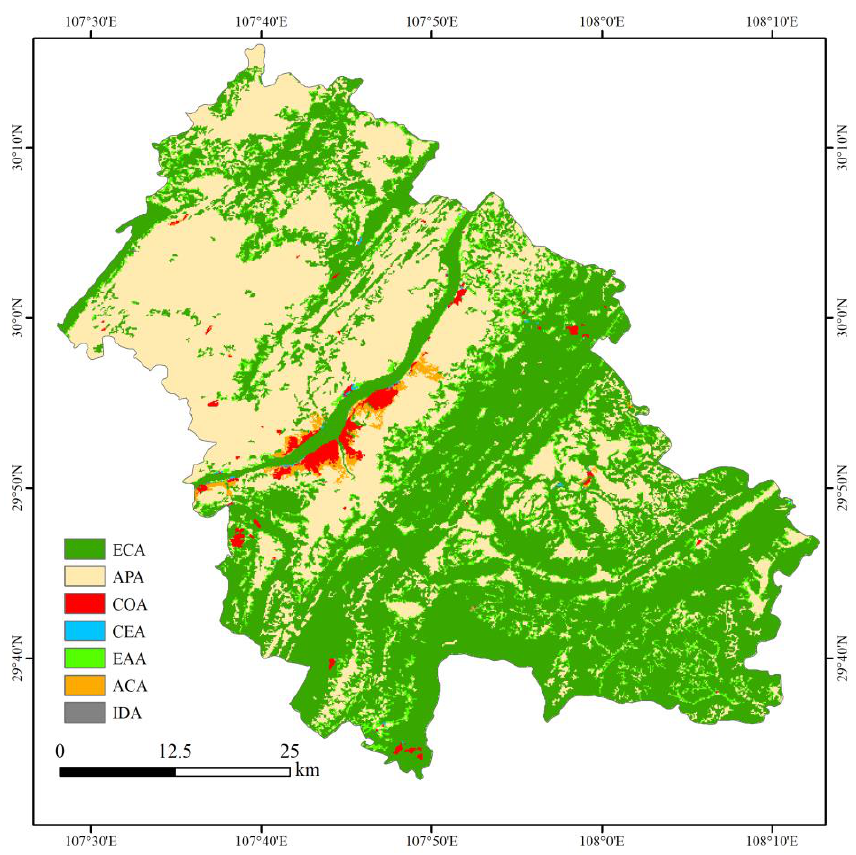
Figure 6. Land optimization zoning results of Fengdu County in 2030.